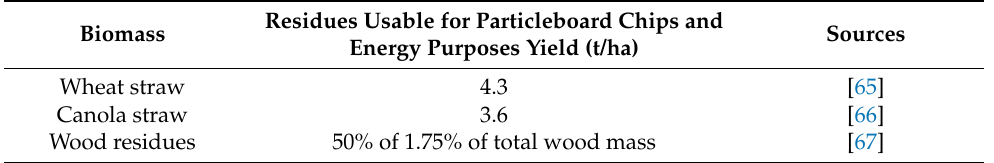
Table 1. Average yield of post-harvest residues and wood biomass residues that can be utilised in the process of particleboards and/or energy production.